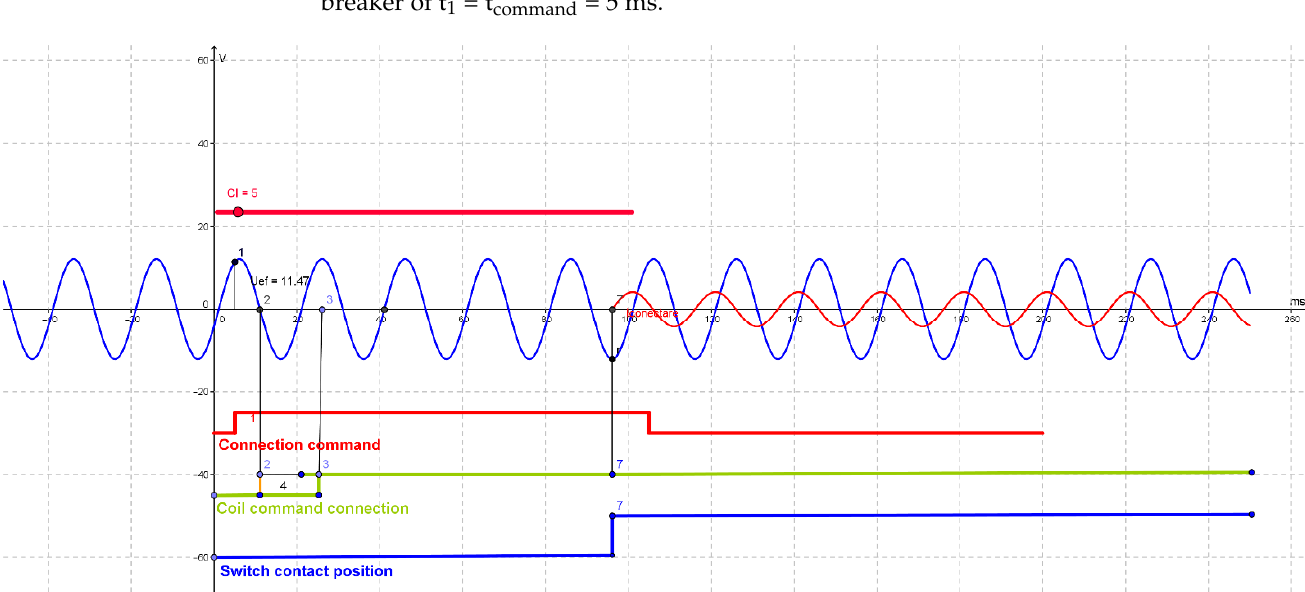
Figure 22. Time delay characteristic of the oil pressure on the connection of a circuit breaker.